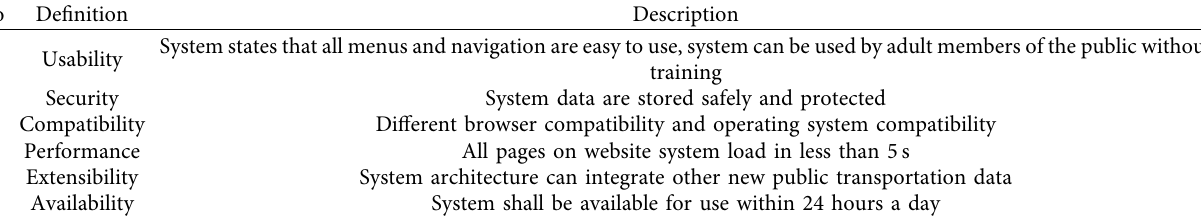
Table 4: Non-functional requirement.